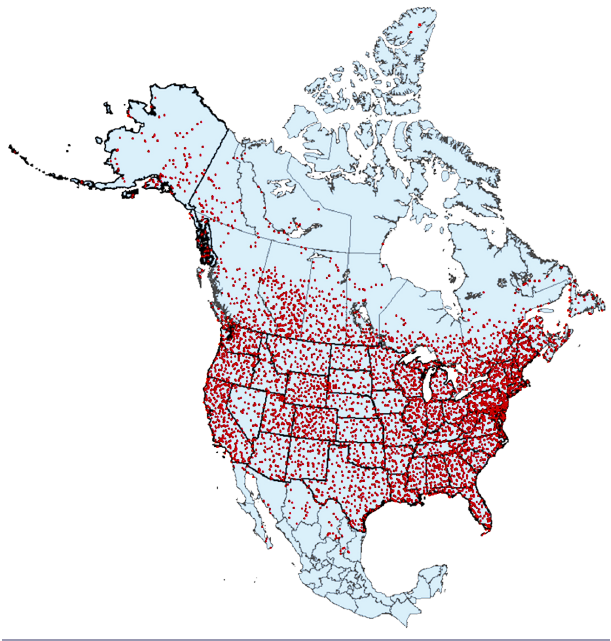
Fig. 2 . Map of Breeding Birds Survey routes in Canada, the U. S., and Mexico, courtesy of the U.S. Geological Survey. (Not all routes are surveyed every